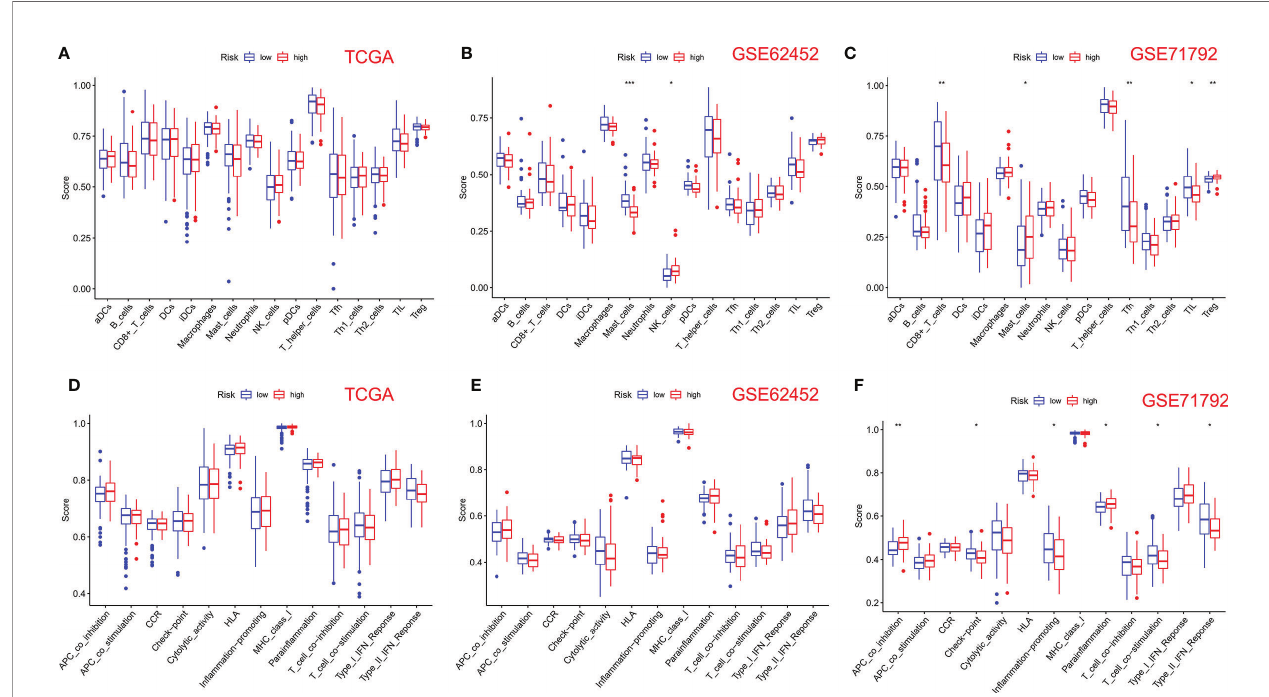
FIGURE 5 | Comparison of ssGSEA scores for immune cells and cascades. (A, D) Comparison of enrichment scores of 16 types of immune cells and 13 immune- related cascades between low- (blue box) and high-risk (red box) groups in TCGA cohort. (B, E) Comparison of tumor immunity between low- (blue box) and high- risk (red box) groups in the GSE62452 cohort. (C, F) Comparison of tumor immunity between low- (blue box) and high-risk (red box) groups in the GSE71792 cohort. P-values were shown as follows: ns, not signi fi cant; *P < 0.05; **P < 0.01; ***P <